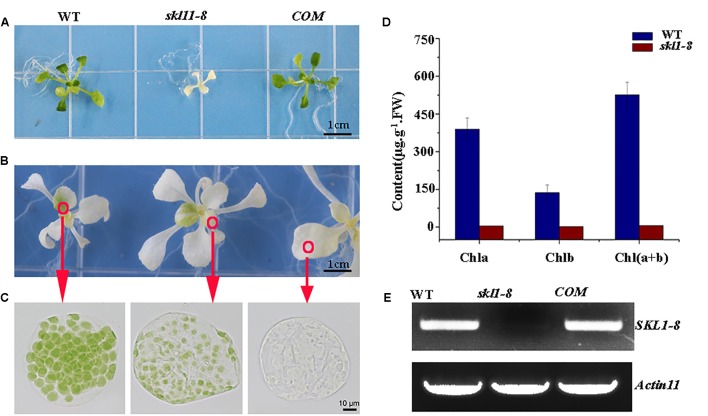
Identification of the skl1-8 mutant. (A) Identification and complementation of the skl1-8 mutant. The cDNA of the wild-type SKL1 with the flag sequence was cloned into a binary plant transformation vector and used for complementation of the skl1-8 mutant (COM). WT, wild type. 14-day-old plants, including WT, skl1-8, and COM, were grown on sucrose-supplemented medium. Scale bar: 3 mm. (B) Different yellow-green phenotype in skl1-8 mutant. (C) Chloroplast phenotypes of mesophyll cells in skl1-8 mutant with different yellow–green phenotype. (D) Reverse transcription (RT)-PCR analysis. RT-PCR was performed using specific primers for SKL1 or ACTIN11. (E) Mean values of chlorophyll contents (Chla and Chlb) in WT and skl1-8 mutant seedlings. Leaf tissue was sampled from 14-day-old plants and data are mean values of three measurements ± SD.